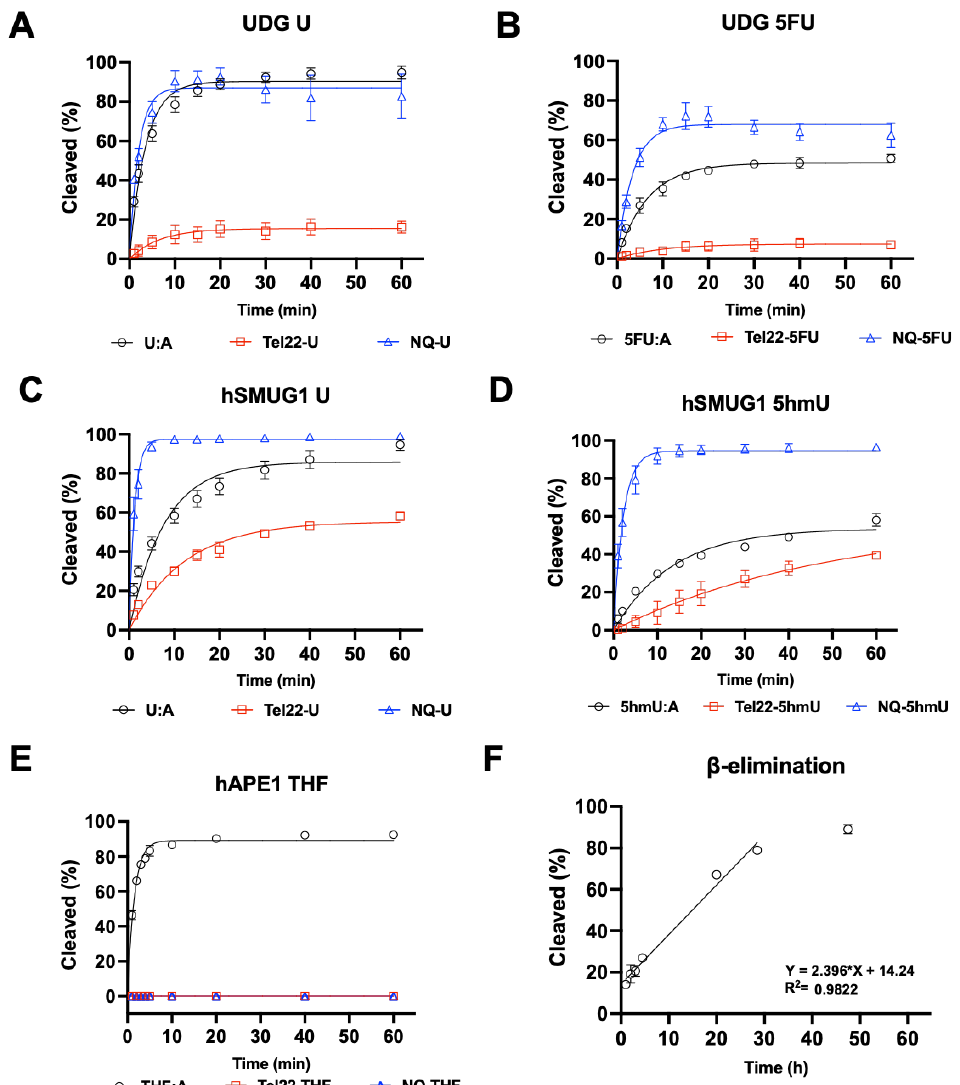
Figure 3. Quadruplex inhibited DNA glycosylase and APE1 activity. UDG, hSMUG1, and APE1 activity on quadruplex oligonucleotides (Tel22-X) containing U, 5hmU, 5FU, or THF was compared to duplex, or single-stranded DNA using the NQ-X oligonucleotides. ( A ) UDG (0.613 nM, 300:1 DNA to enzyme ratio) was fastest on single-stranded U (NQ-U) and duplex (U:A) followed by quad- ruplex (Tel22-U). ( B ) UDG (6.13 nM, 30:1 DNA to enzyme ratio) was overall less efficient on 5FU but the trend was the same, NQ-5FU > 5FU:A > Tel22-5FU. ( C , D ) hSMUG1 (6.2 nM, 30:1